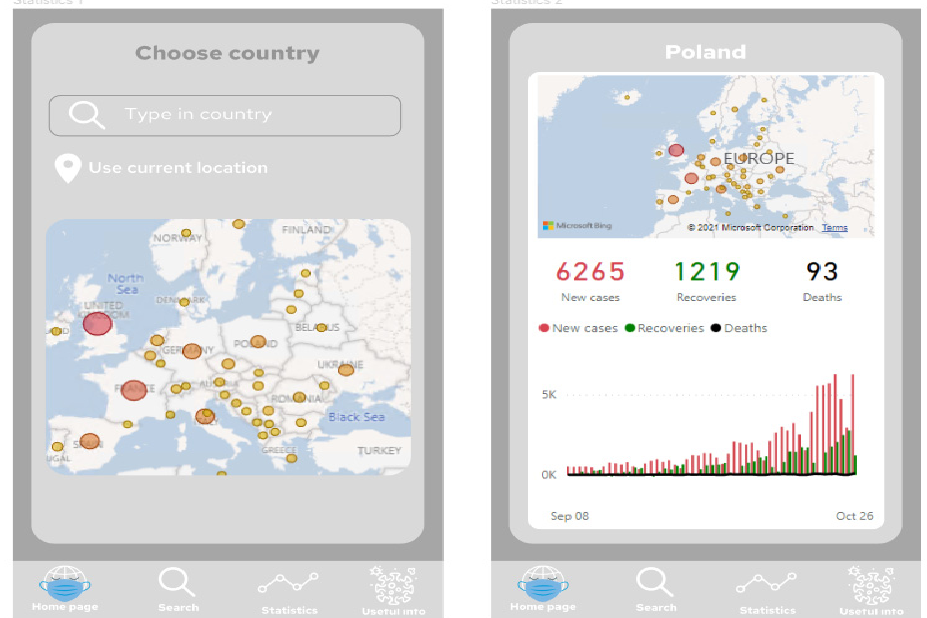
Figure 9. The first and second screen with the statistics in the application—choosing location and Power BI report embedded in the application. Source: Authors own elaboration.